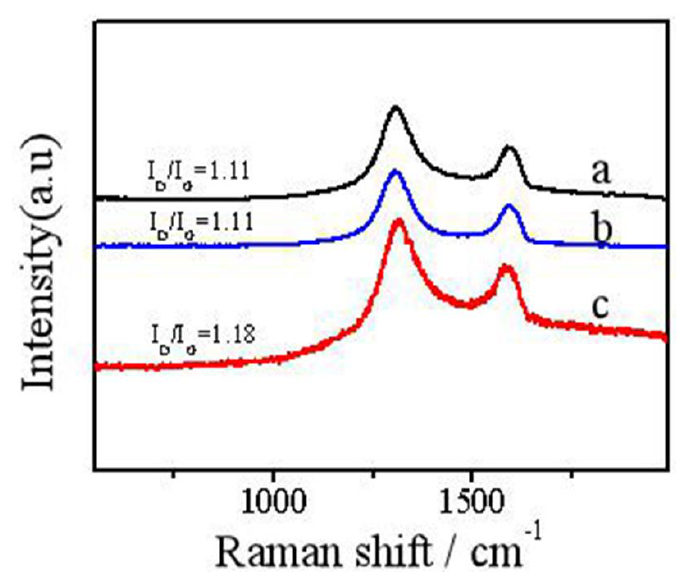
Figure 4. Raman spectra: Pt-Bi (Bi 2 O 3 )/GNs (PVP) ( a ), Pt/GNs (PVP) ( b ), Pt-Bi (Bi 2 O 3 )/GNs ( c ).